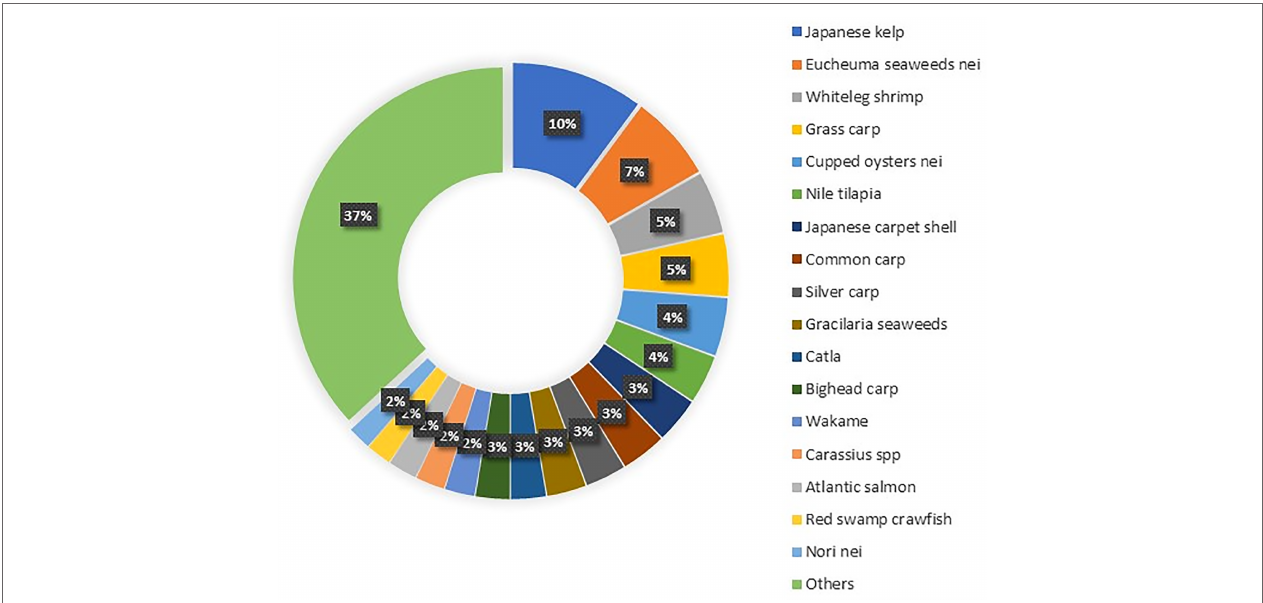
FIGURE 2 | Major cultivated aquaculture species (FAO,